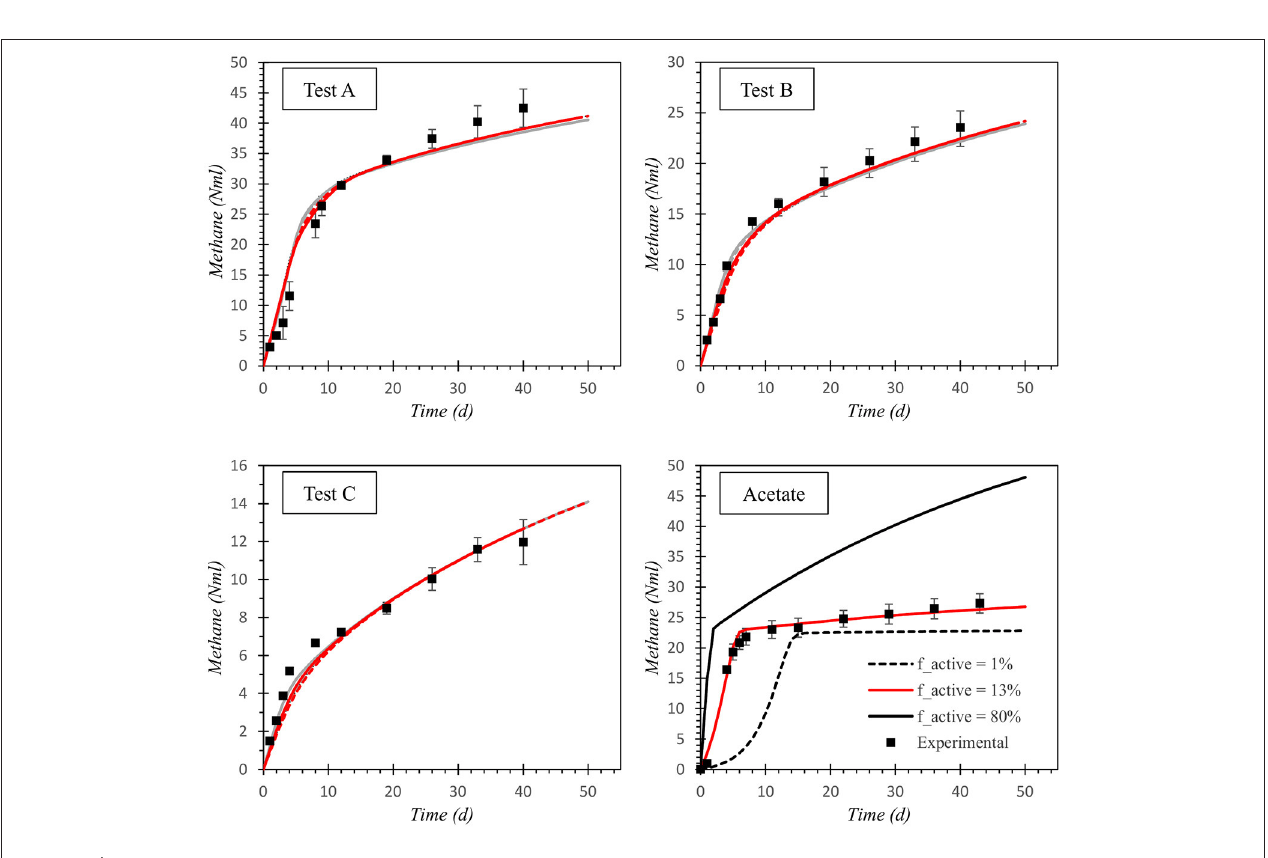
FIGURE 2 | Simulation results for Experiment 1, with Tannery Primary Sludge ( Default ADM1; 1st order disintegration; Contois disintegration; Rapid/Slow_1st order Disintegration; Rapid/Slow_Contois Disintegration;